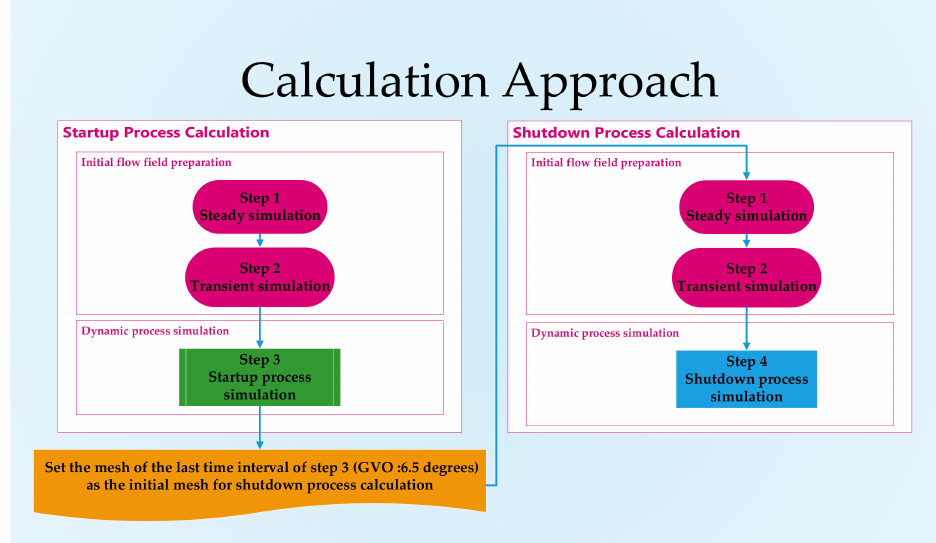
Figure 6. Workflow of the